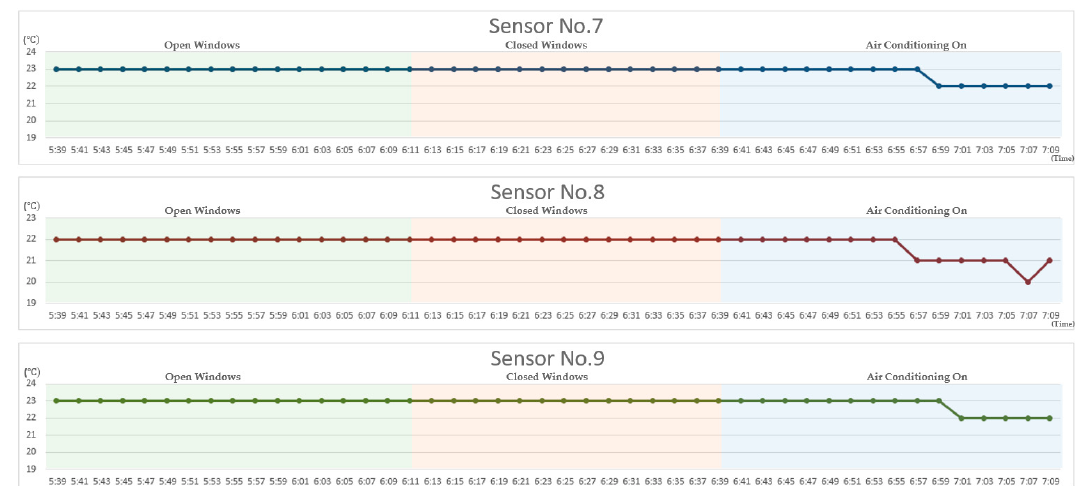
Figure 15. Temperature data for sensors 1–9.